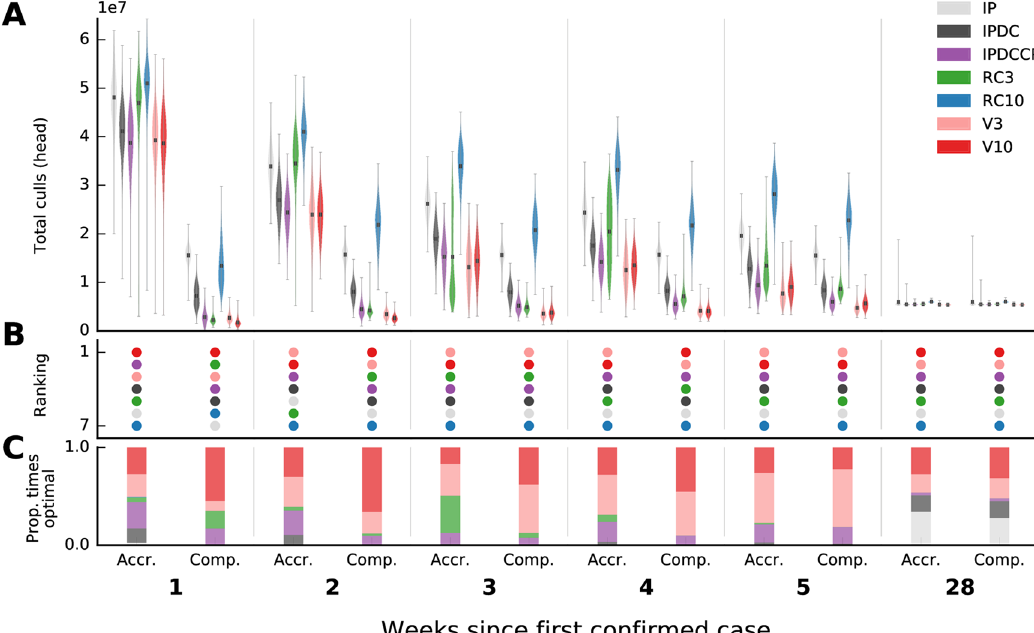
Fig 2. Projections and relative rankings of various control strategies of total animals culled, and estimates of infected but undetected farms, for the first five weeks and the final week of the 2001 foot-and-mouth disease outbreak in UK. A) Distribution of total animal culls from forward simulations, here shown as kernel density estimates (violin plots), are seeded either using parameter estimates from the end of the outbreak (Comp.; ‘complete’), or at the specific time point (Accr.; ‘accrued’). B) Rankings of control interventions are according to mean projections. Proportion (C) of times each control was optimal when bootstrap samples are made from distributions in (A). For all time points see S9 and S10